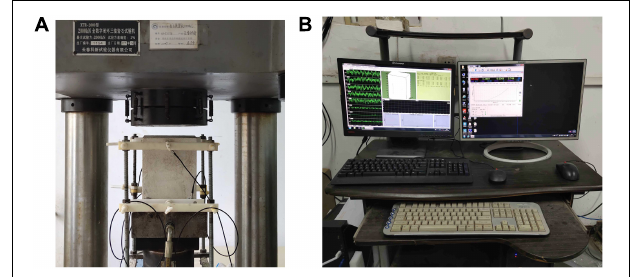
FIGURE 6 | Images showing the XTR-2000 loading device (A) and computer console (B)